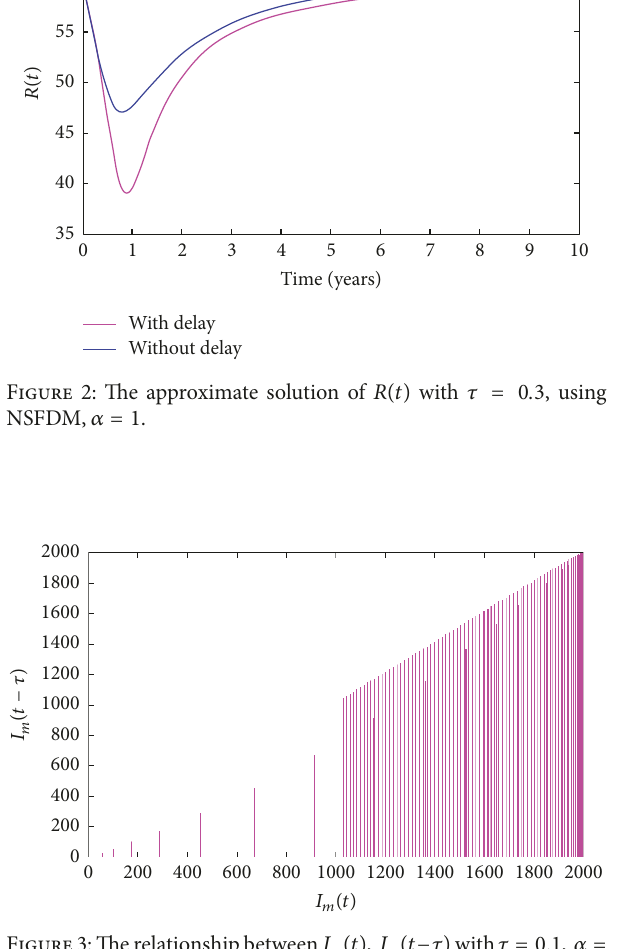
Figure 3: The relationship between 𝐼 𝑚 (𝑡) , 𝐼 𝑚 (𝑡−𝜏) with 𝜏 = 0.1 , 𝛼 = 1 using NSFDM.